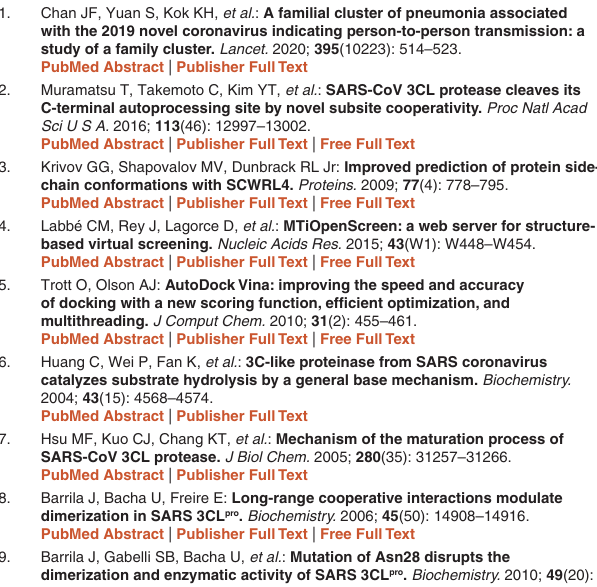
Tab S1.docx (Sequence homology of the 3CL pro cleavage junctions of PP1AB between SARS-CoV-2 and SARS-CoV).